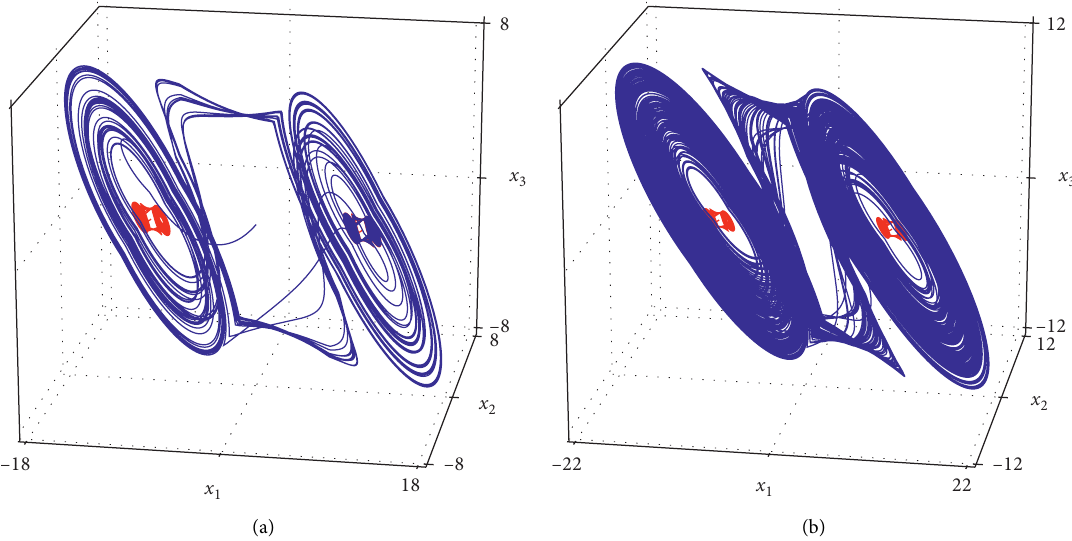
Figure 2: Simulation of the system given by (1), (2), (4), and (30) with a � 0 . 2 ,b � 5 ,c � − 3 , α � 1 , c � 10, and α � 1 for the initial condition x � ( 0 , 0 , 0 ) T in blue. In (a) the surfaces are defined by (33) and (34), the simulation is shown for t ∈ [ 0 , 300 ] a · u . (arbitrary units), and the trajectory converges to one of the self-excited attractors in red. In (b) the surfaces are defined by (35) and the simulation is shown for t ∈ [ 50000 , 51000 ] a · u ., and the hidden attractor